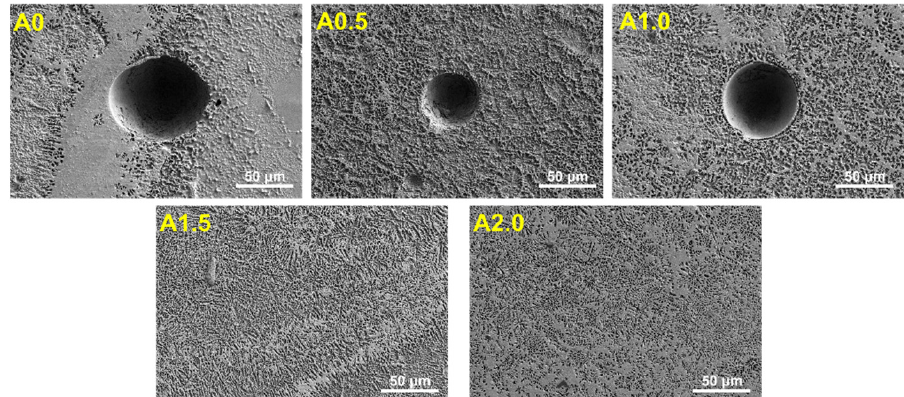
Figure 10. Typical morphology of the in the turbulence area of the weld seam cladded with different oscillating amplitudes.